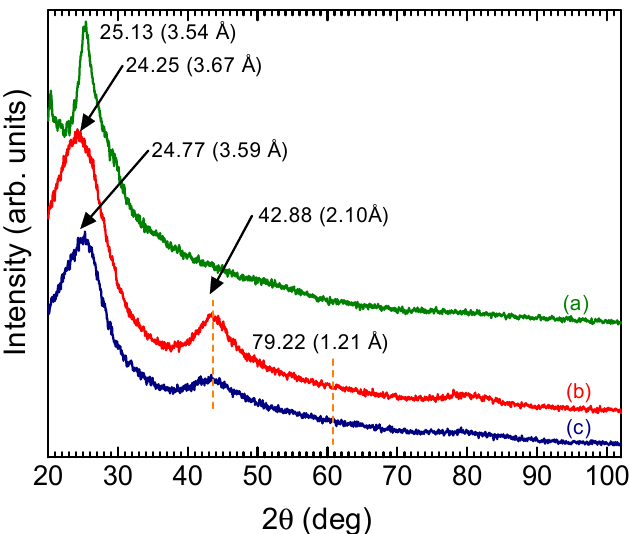
Figure 6. X-ray diffraction (XRD) profiles. ( a ) PANI-(+)-CSA; ( b ) CB(PANI); ( c ) V-CB(PANI).